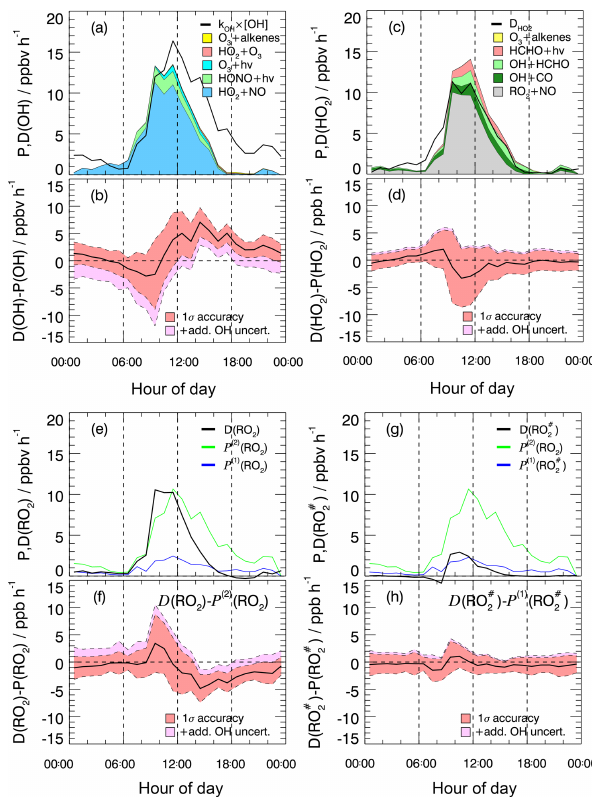
Figure 3. Experimental budgets for OH (a, b) , HO 2 (c, d) , RO 2 (e, f) , and RO # (g, h) . In the respective upper panels (a, c, e, g) , solid 2 black lines denote the median total destruction rates. The colored ar- eas in (a) and (c) represent cumulative plots of the production rates from different reactions. The blue solid lines in (e) and (g) denote the production rates P ( 1 ) and P ( 1 ) , respectively, calculated from RO 2 RO # 2 measured VOCs (Eq. 7). The green lines represent P ( 2 ) calculated RO 2 from k OH (VOC(2)) (Eq. 8). In all four budgets (OH, HO 2 , RO 2 , RO # ) the contribution of the radical production from ozonolysis is 2 so small that it is hardly visible. The respective lower panels (b, d, f, h) show the difference between the total destruction and pro- duction rates. Red shaded bands indicate the 1 σ uncertainty due to experimental errors of the measured quantities (Table S1) and the reaction rate coefficients. The pink shaded areas represent the max- imum possible bias from a potential OH